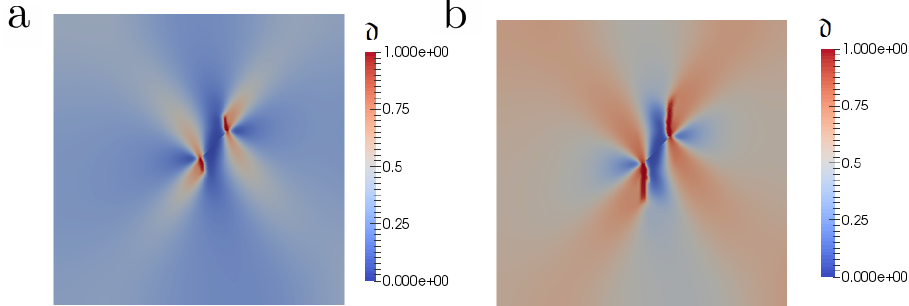
Figure 5. Uniaxial compression case: Failure pattern at an initial stage ( a ) and at advanced stage ( b